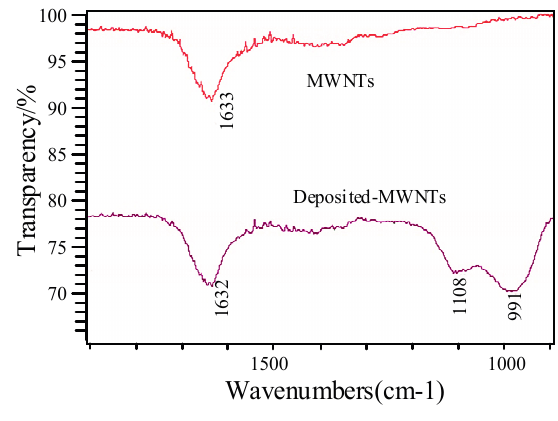
Figure 6. Infrared absorption spectra of MWNTs and deposited